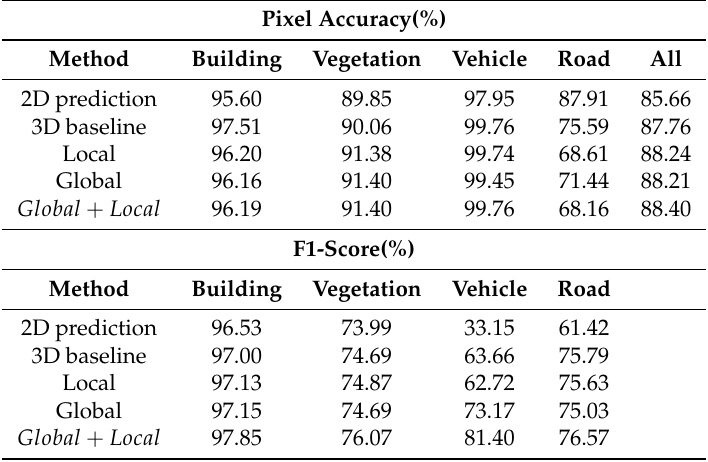
Table 2. Quantitative results of different methods for semantic